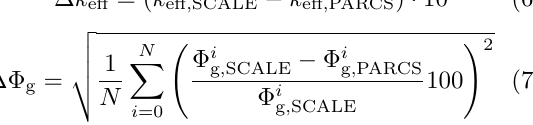
Figure 1. Visualisation of the test case model